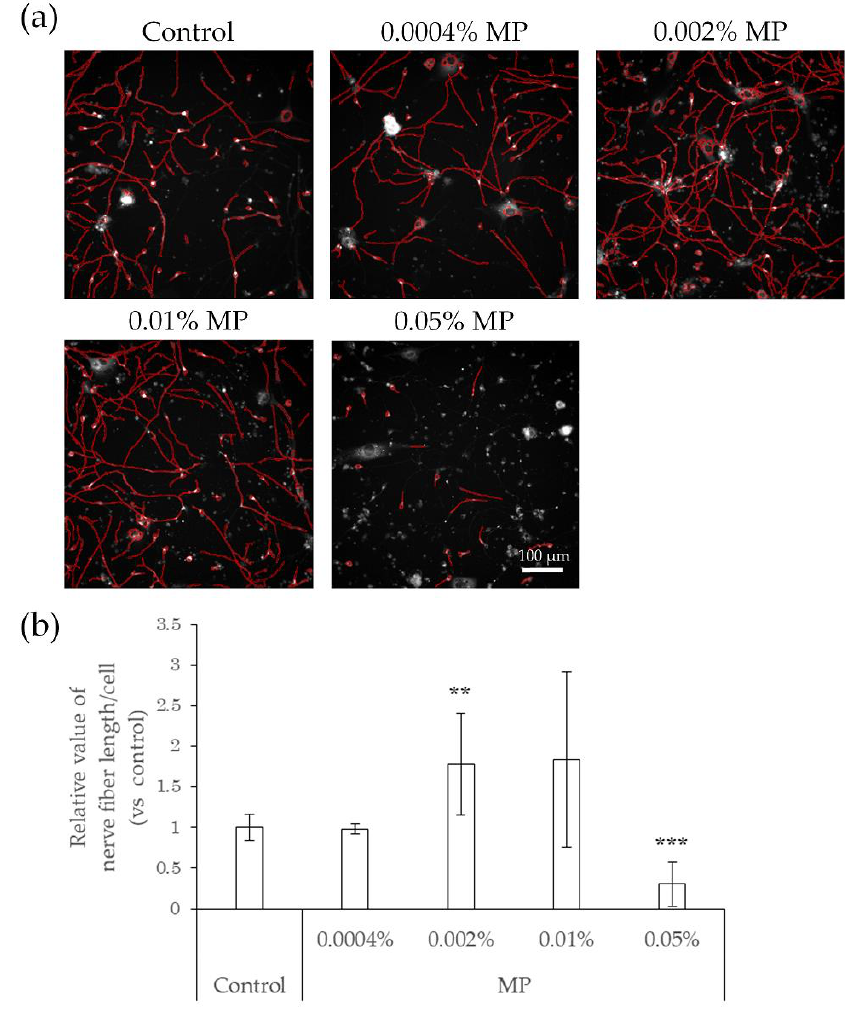
Figure 3. Effects of direct action of MP on nerve fiber elongation of hiPSC-SNs. After culturing for 3 days, hiPSC-SNs were incubated with medium containing MP for 24 h and stained with NeuO. ( a ) Representative images with nerve fibers outlined in red were obtained using IN Cell Analyzer 2200. The red lines indicate NeuO-stained nerve fibers. ( b ) Nerve fiber length per cell versus the control after incubation with various doses of MP. Each value represents the mean ± standard deviation of 4–25 wells. ** p < 0.005, *** p < 0.001, vs. the control (Steel’s test). MP: